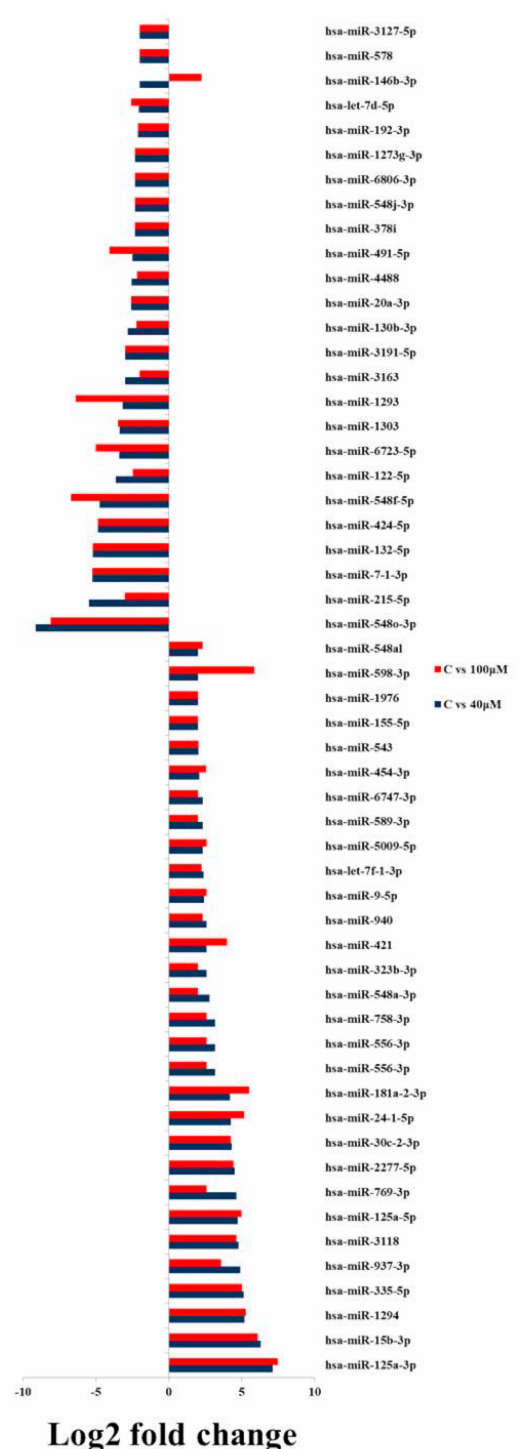
Figure 7. Common up- and down-regulated microRNAs between untreated control vs. 40 and the untreated untreated control vs. 100 µ M EGCG control vs. 100 μ M EGCG treatments.